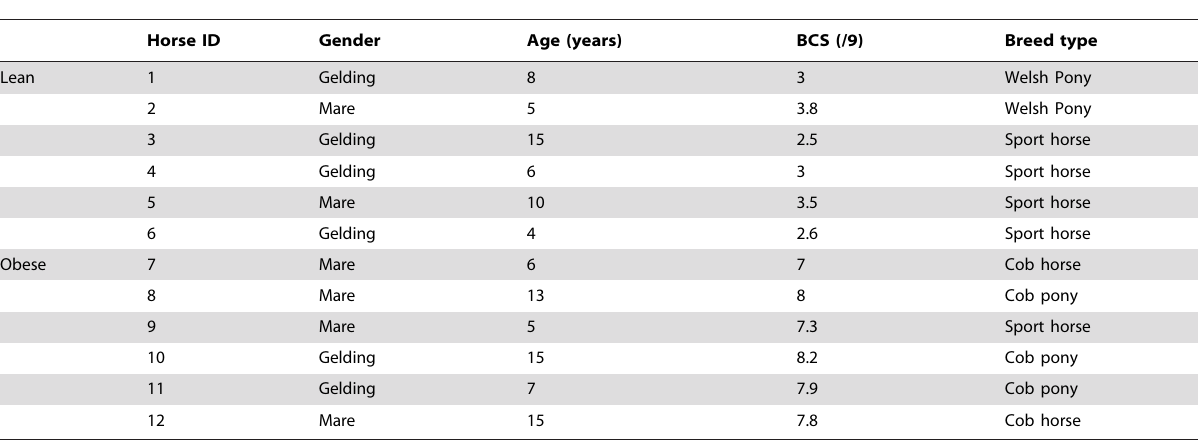
Table 1. Phenotypic descriptors for the animals used in this study.